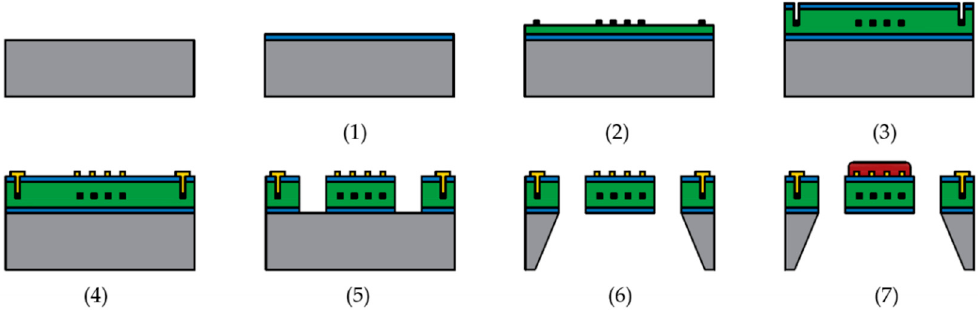
Figure 10. Fabrication processes of a suspended membrane microhotplate with backside etching.